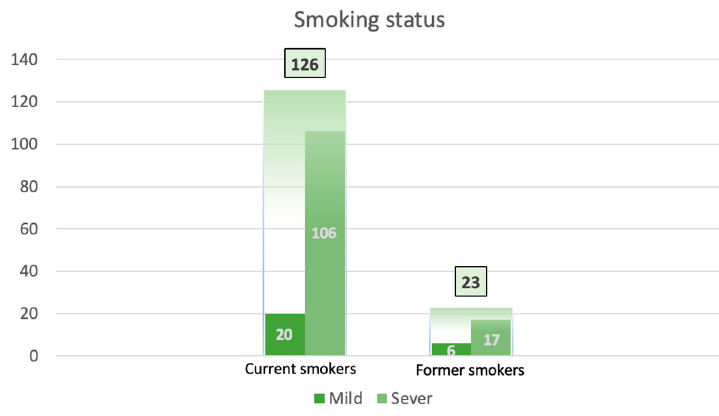
Figure 3. Smoking